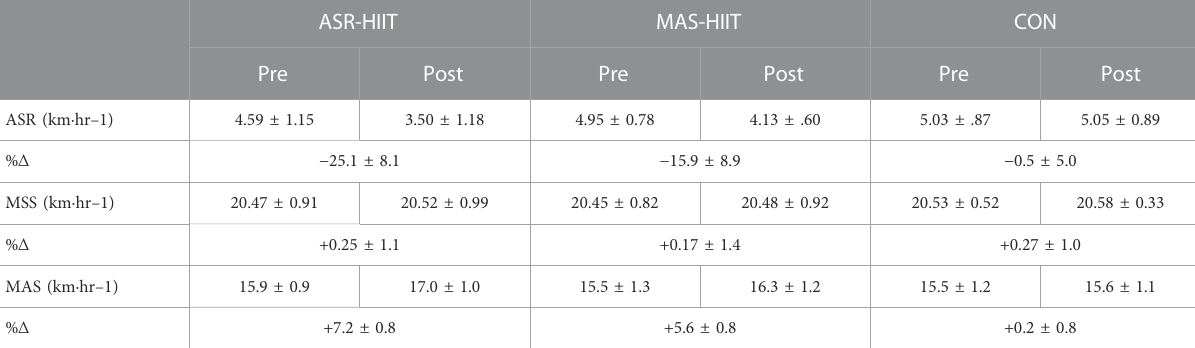
TABLE 2 Pre-training vs. post-training values for anaerobic speed reserve (ASR), maximal sprint speed (MSS), and maximal aerobic speed (MAS). ASR-HIIT MAS-HIIT CON Pre Post Pre Post Pre